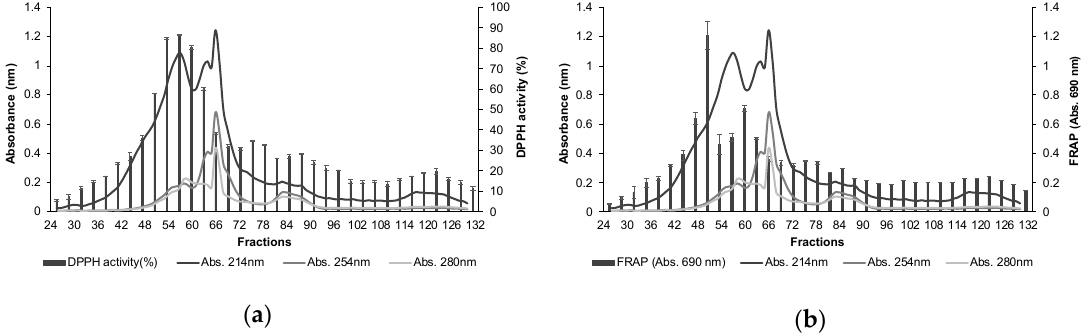
Figure 3. Size-exclusion chromatography profile of tomato by-products hydrolysate and antioxidant activity determined by ( a ) DPPH radical scavenging activity and ( b ) ferric reducing antioxidant power (FRAP) of each of the three pooled fractions.